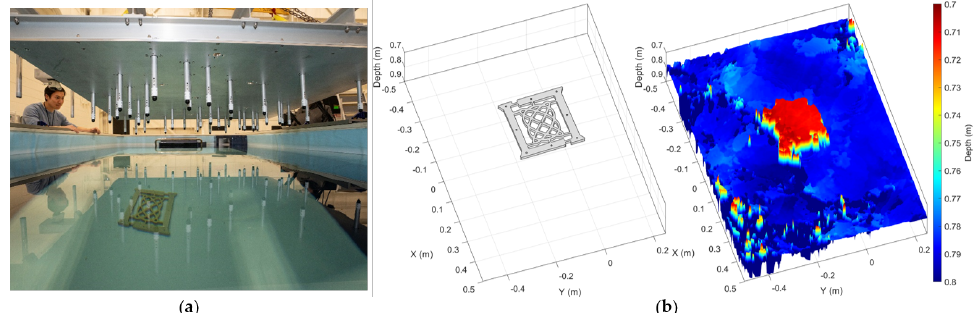
Figure 7. ( a ) The 200 kHz sparse aperture sonar array above the test tank and ( b ) CAD model of the target and acoustic reconstruction example.